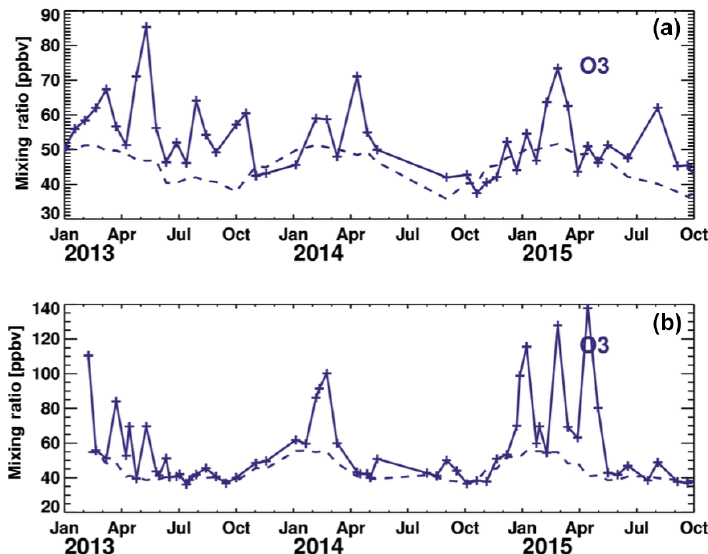
Figure A1. Time series of transect means (solid lines) and corresponding a priori means (dashed lines) for the MCMA (a) and the Lagos area (b) .